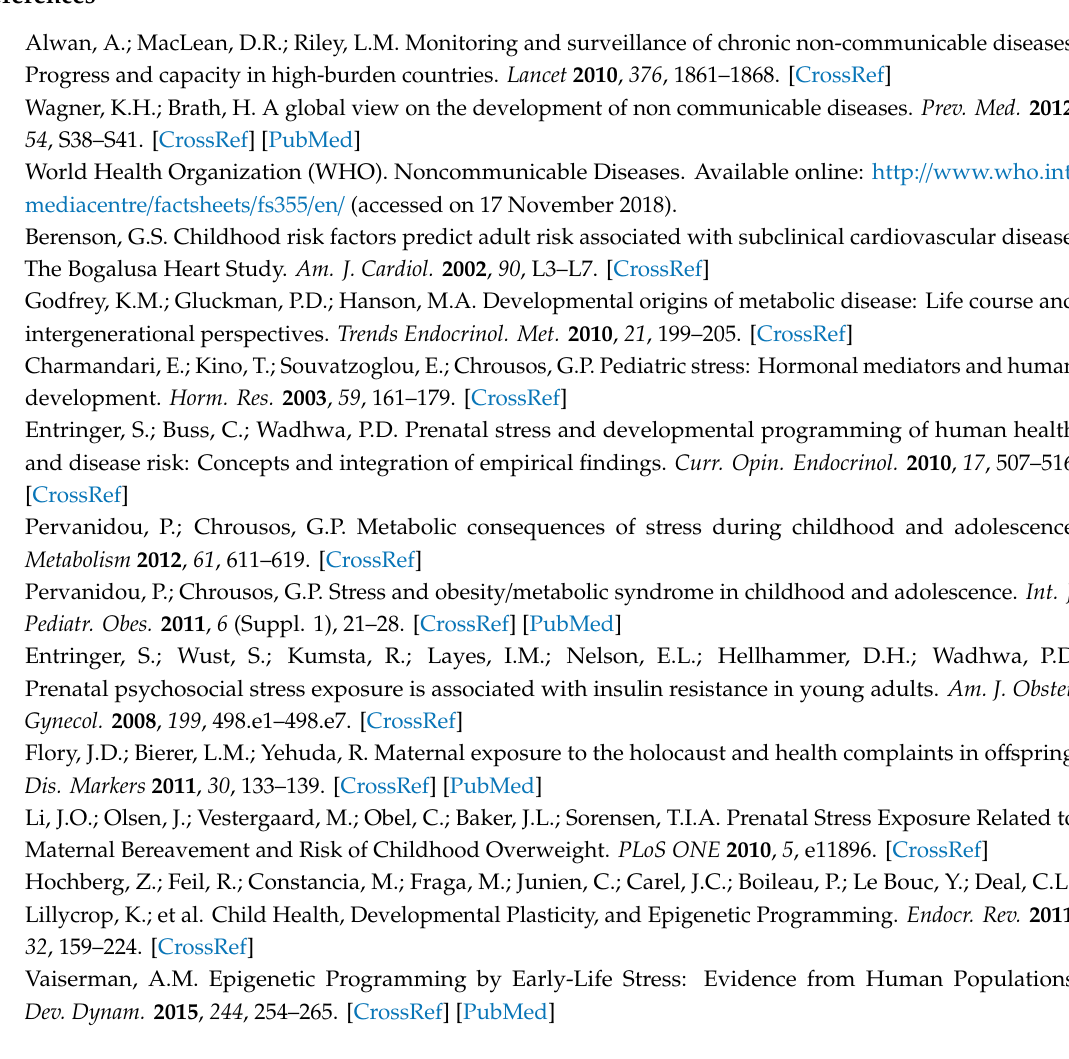
Table S1: Association of children’s level of lipid biomarkers with maternal experience of any emotional DV before and after